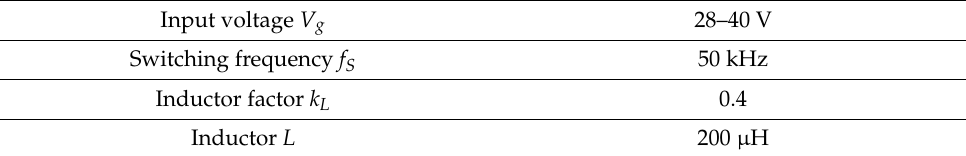
Table 3. Parameters of the hybrid switched-capacitor boost converter.